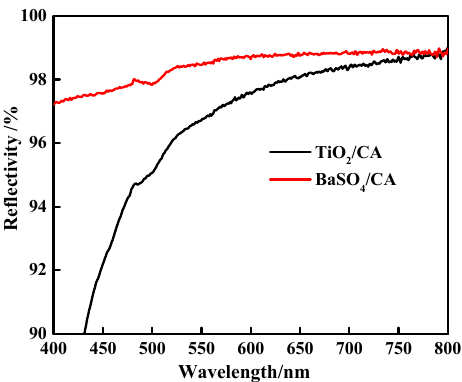
Figure 7. Light reflectivity of BaSO 4 bifunctional sheet and TiO 2 bifunctional sheet.